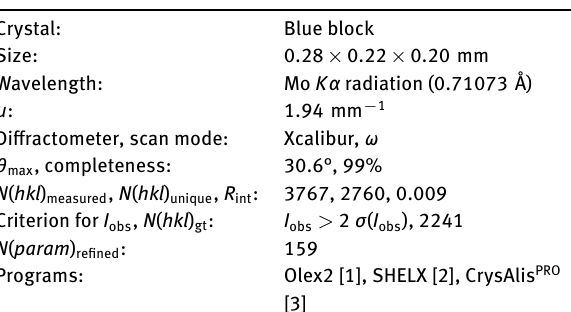
Table 1: Data collection and